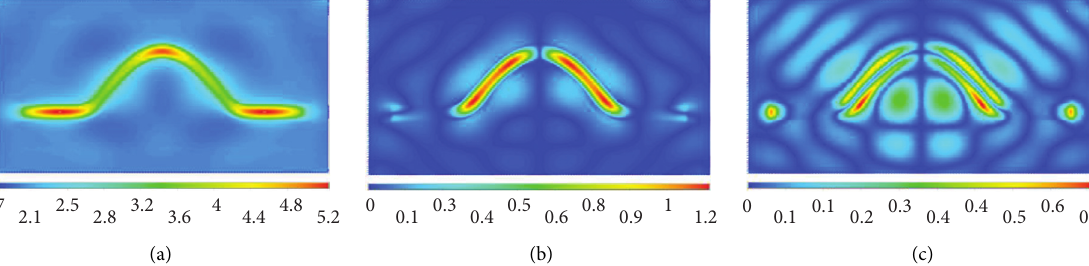
Figure 56: SV wave incident (NR � 1, f � 1.5.0Hz, H � 100m, and C